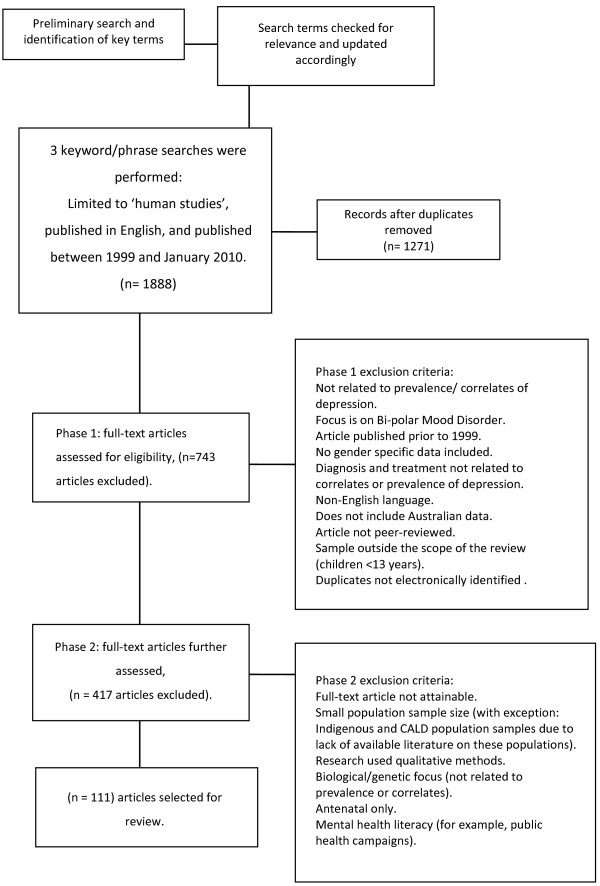
PRISMA flow chart.